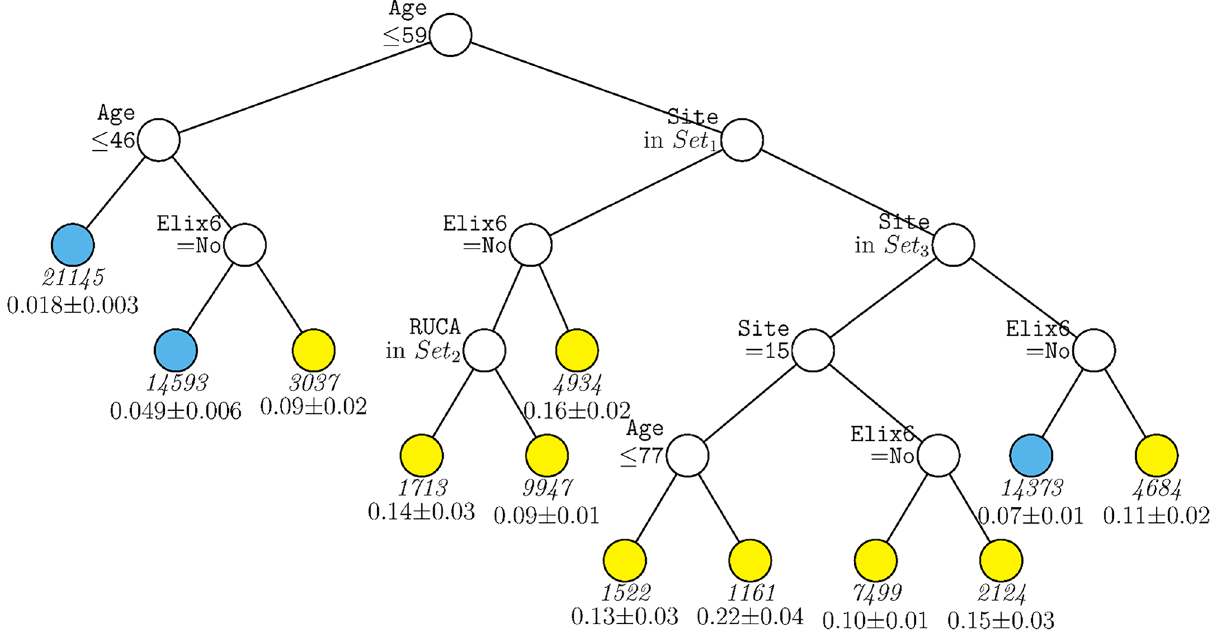
Figure 4. GUIDE subgroup model for differential outcomes for the Subsample. At each split, an observation goes to the left branch if and only if the condition is satisfied. Set 1 = {Site 1, Site 3, Site 7, Site 9, Site 10, Site 12, Site 19, Site 21}. Set 2 = {Micropolitan Area, Rural}. Set 3 = {Site 2, Site 5, Site 11, Site 15, Site 16}. Sample sizes (in italics) and 95% simultaneous confidence intervals for mortality rate printed below nodes. Terminal nodes with means above and below value of 0.073 at root node are colored yellow and skyblue respectively.